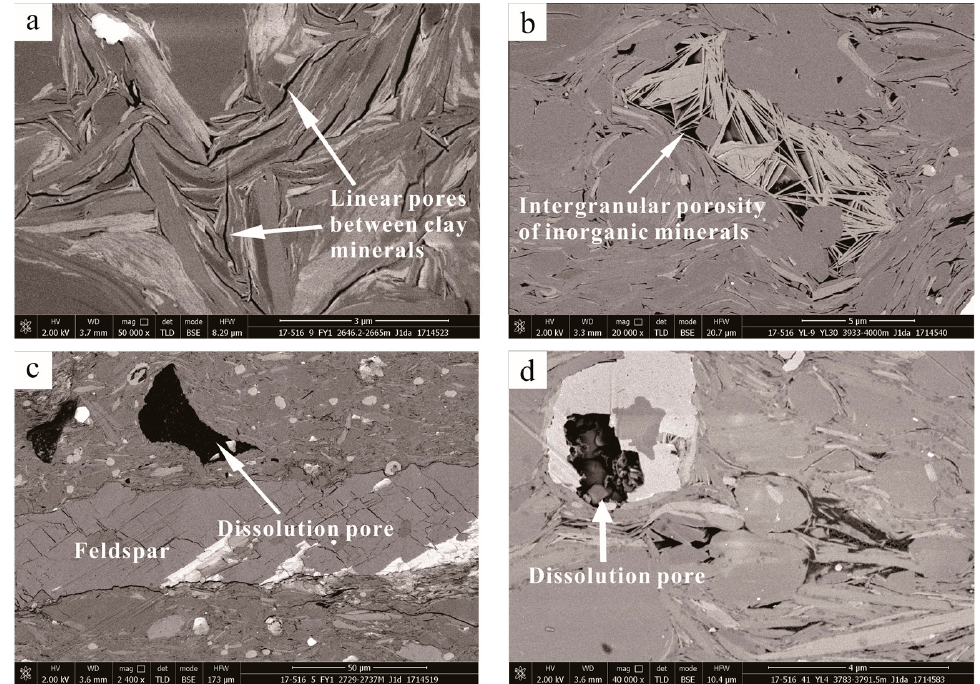
Figure 4. Microscopic characteristics of inorganic mineral pores in Da’anzhai shale by scanning electron microscopy. ( a ) Linear pores between clay minerals, Well FY1, 2646.2 m, Da’anzhai section. ( b ) Inorganic mineral intergranular pores, Well FY1, 3933 m, Da’anzhai section. ( c ) Nanoscale intragranular dissolution pores, Well FY1, 2737 m, Da’anzhai section. ( d ) Micron-scale intragranular dissolution pores, Well YL4, 3783 m, Da’anzhai section.